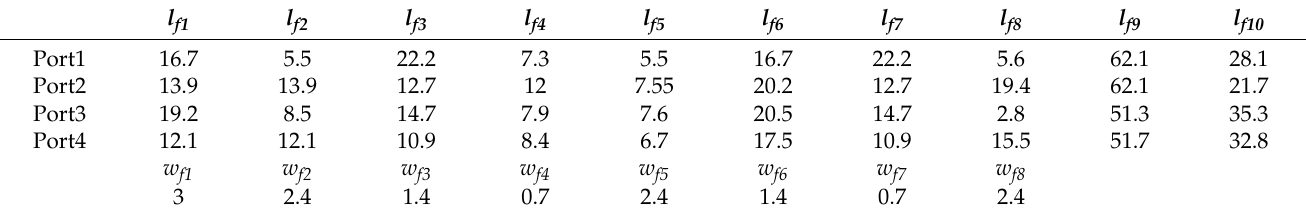
Figure 5. Topology of the feed network on the bottom layer. Table 2. Dimensions of the four-port feed network (mm).